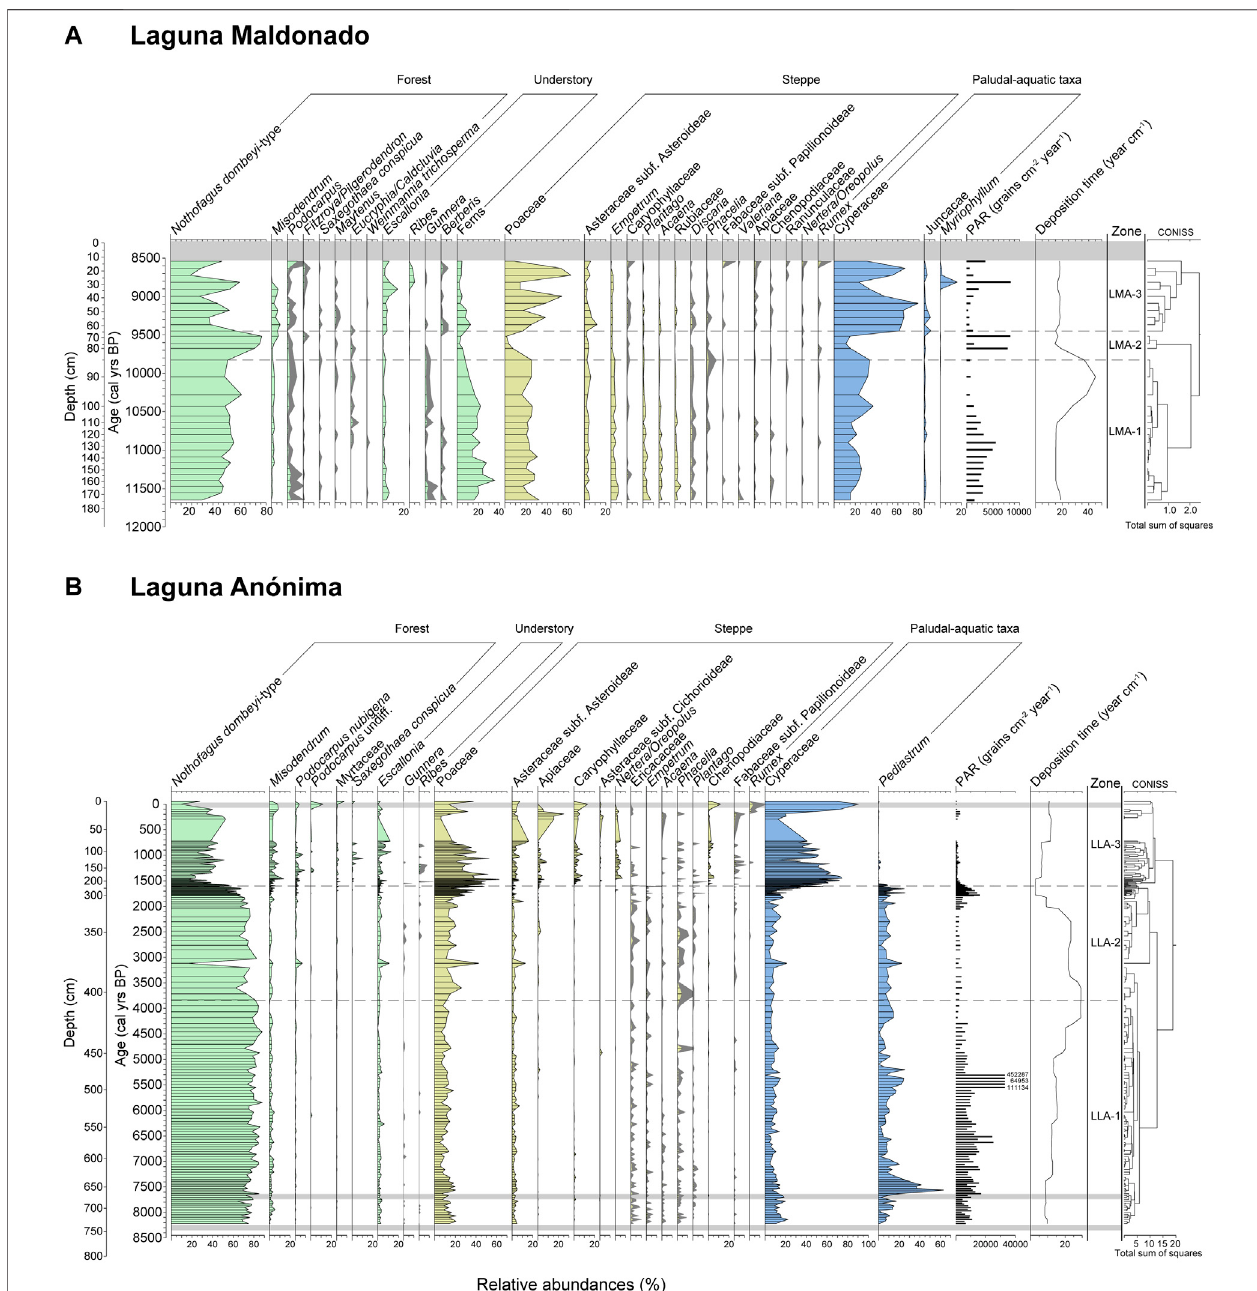
FIGURE 4 | Pollen diagrams of (A) Laguna Maldonado and (B) Laguna Anónima in percentages including the total pollen accumulation rate (PAR; grains cm − 3 year − 1 ), the deposition time (year cm − 1 ), and the CONISS analysis. Dashed lines denote the pollen zones, and gray horizontal lines denote the position of tephra layers. Gray shadows in some curves of pollen types indicate an exaggeration factor of 4x.